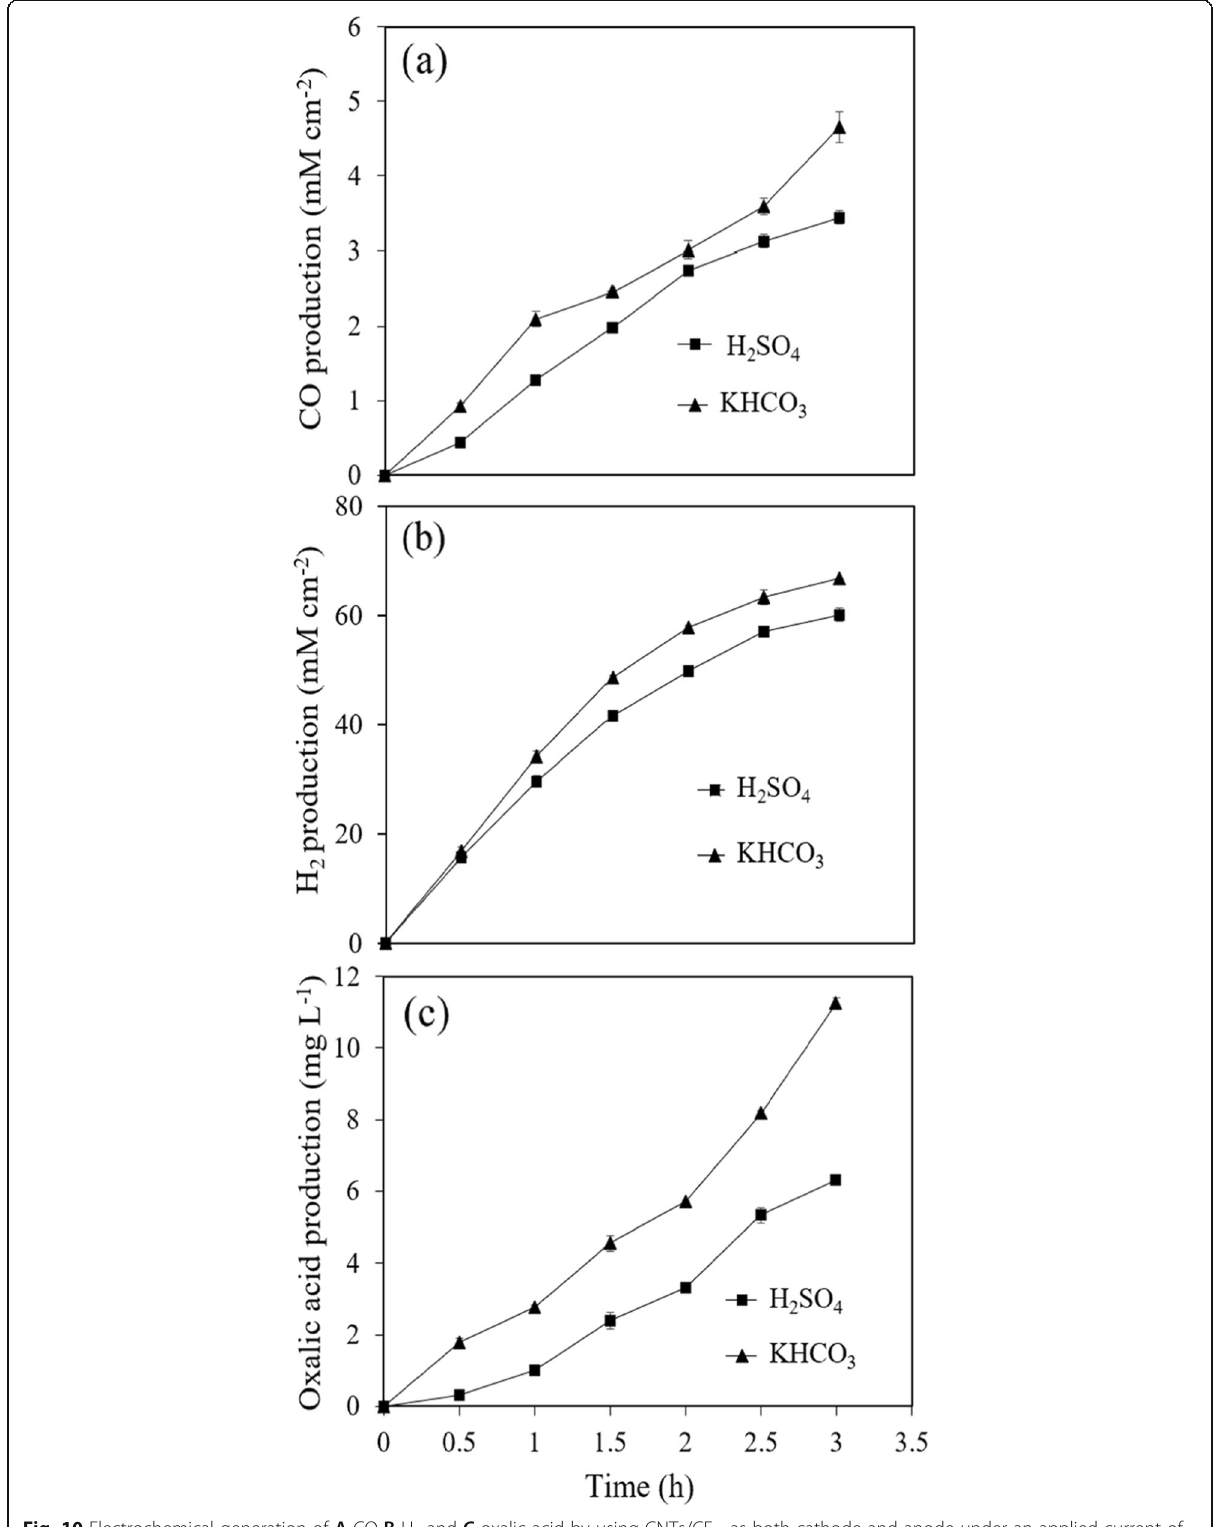
Fig. 10 Electrochemical generation of A CO B H 2 and C oxalic acid by using CNTs/CF M as both cathode and anode under an applied current of 50 mA in various electrolytes. Initial pH values of the solutions are 1.86 and 8.22 for 0.1 M H 2 SO 4 and 0.1 M KHCO 3 ,